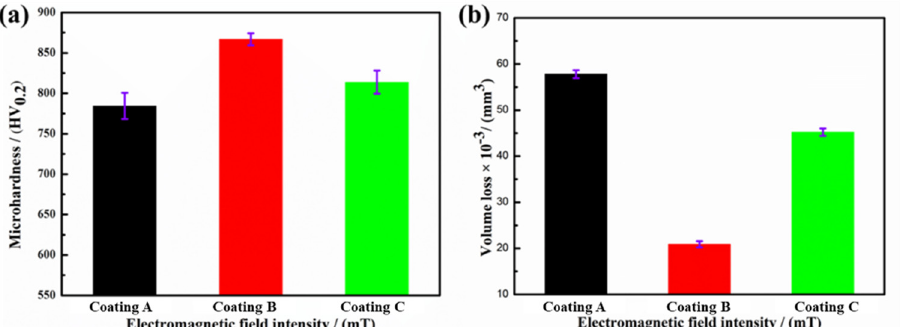
Figure 8. Average microhardness ( a ) and volume loss ( b ) of coatings A (0 mT), B (20 mT), and C (40 mT).